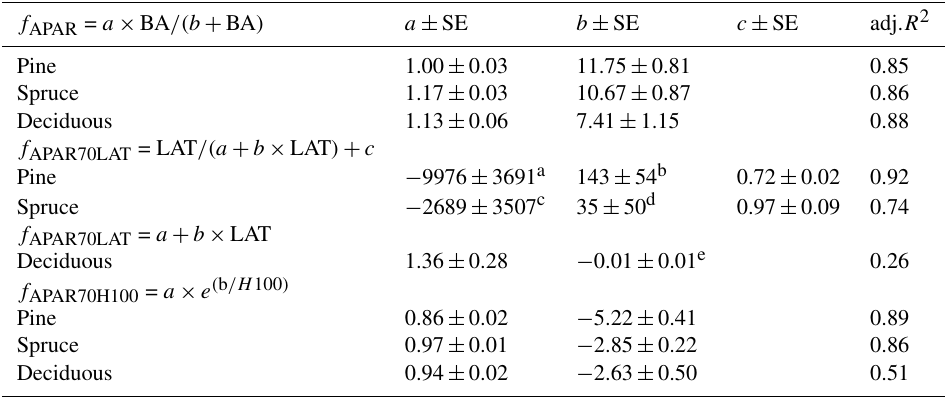
Table A1. Parameter estimates and their standard errors of the f APAR regressions with the stand basal area (BA, m 2 ha − 1 ), and the f APAR70LAT and f APAR70H100 regressions with the latitude (LAT, ◦ ) and with the site productivity index (H100, m) for Scots pine, Norway spruce, and deciduous